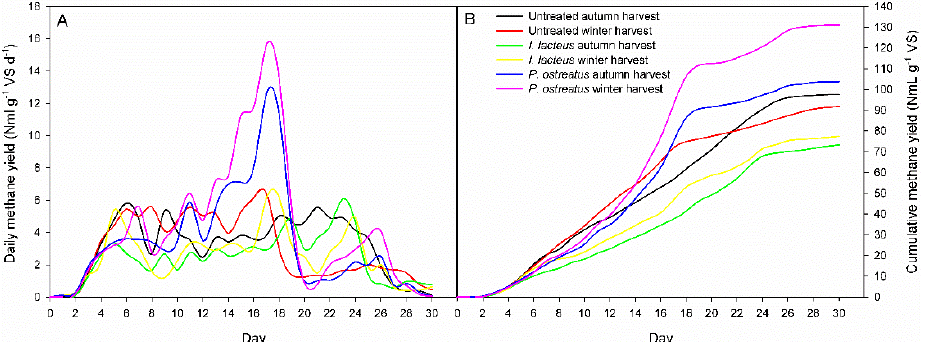
Figure 4. ( A ) Daily methane yield (Nml g − 1 VS d − 1 ) and ( B ) cumulative methane yield (NmL g − 1 VS) for GRB under harvest regimes (autumn and winter) and fungal pretreatments ( I. lacteus and P. ostreatus ). Significant interaction (LSDint p ≤ 0.05) for: (i) DCH 4 (1.34) and ∑ CH 4 (7.22).